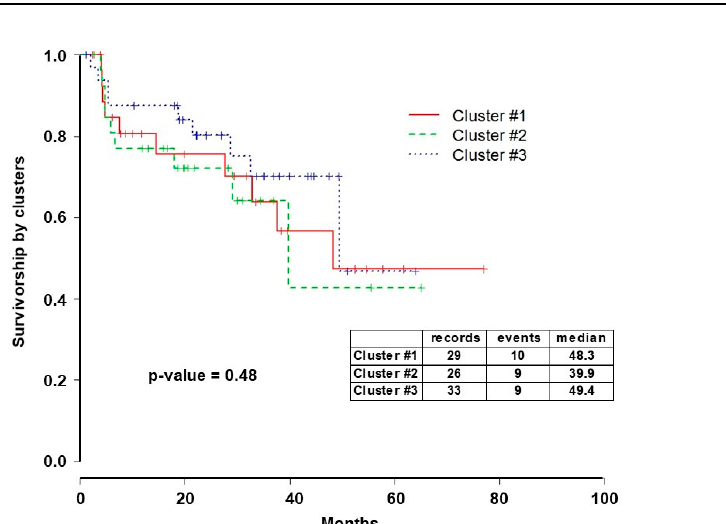
Figure 4. Survival analysis by clusters. Kaplan–Meier survival curves of the three clusters from iClusterPlus analysis showed no differences by log-rank analysis ( p = 0.48).